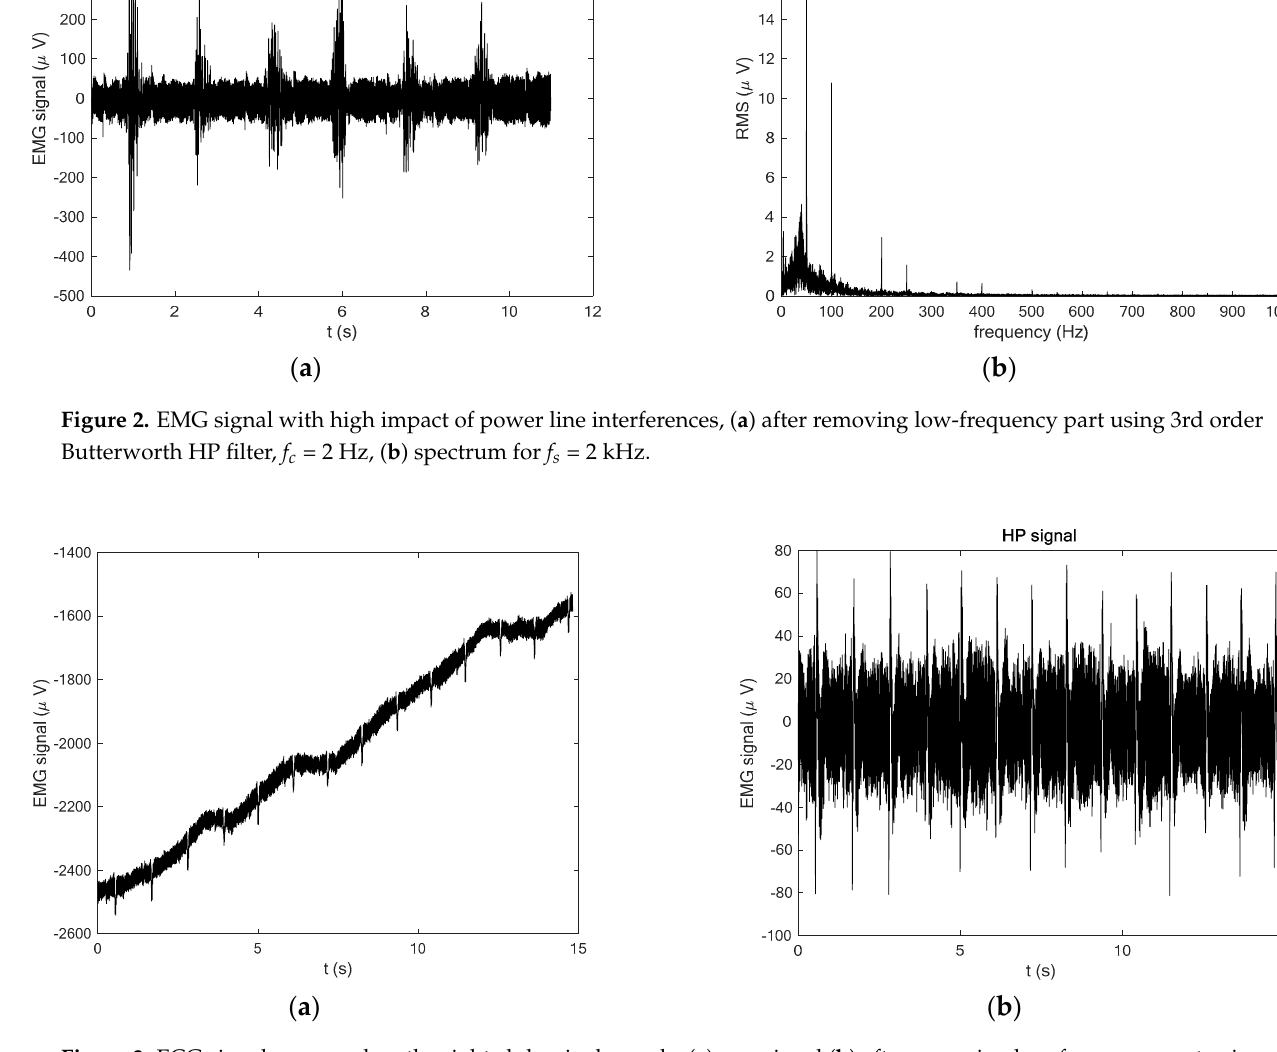
Figure 2. EMG signal with high impact of power line interferences, ( a ) after removing low-frequency part using 3rd order Butterworth HP filter, f c = 2 Hz, ( b ) spectrum for f s = 2 kHz.